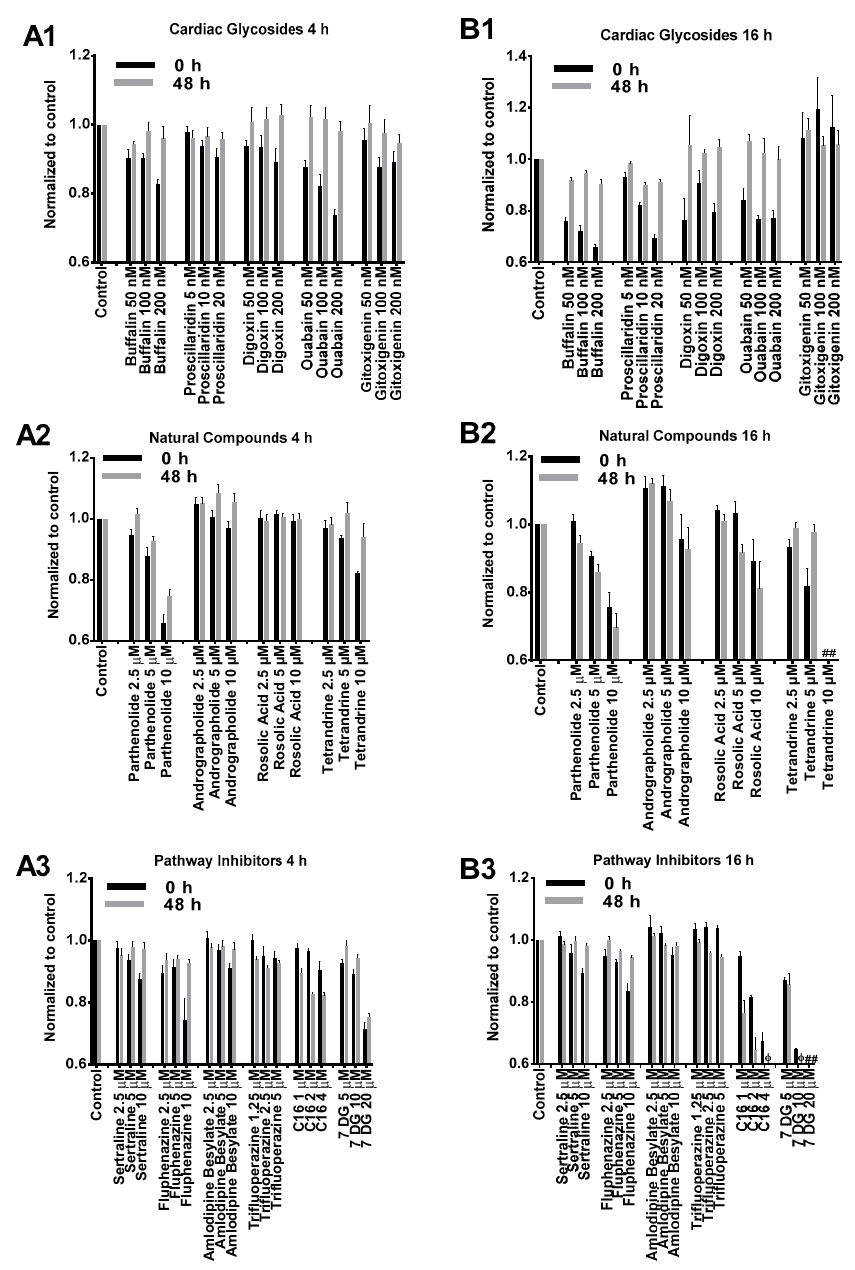
Figure 1. Cytotoxicity profiles of small molecules listed in Table 1. BJ cells were treated with small molecules or dimethyl sulfoxide (DMSO) control for 4 h ( A1–A3 ) or 16 h ( B1–B3 ) followed by cell viability assay (0 h, black columns). Cells were further incubated in complete media without small molecules for another 48 h (grey columns) followed by a second cell viability assay. Cell viability results were normalized to respective DMSO controls in each experiment. # and φ indicate relative viability of <10% and <50% compared to DMSO controls, respectively.